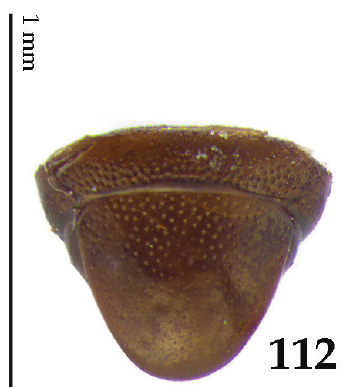
Figure 112. Hypocacculus ( Hypocacculus ) hyla (Marseul, 1864) propygidium +